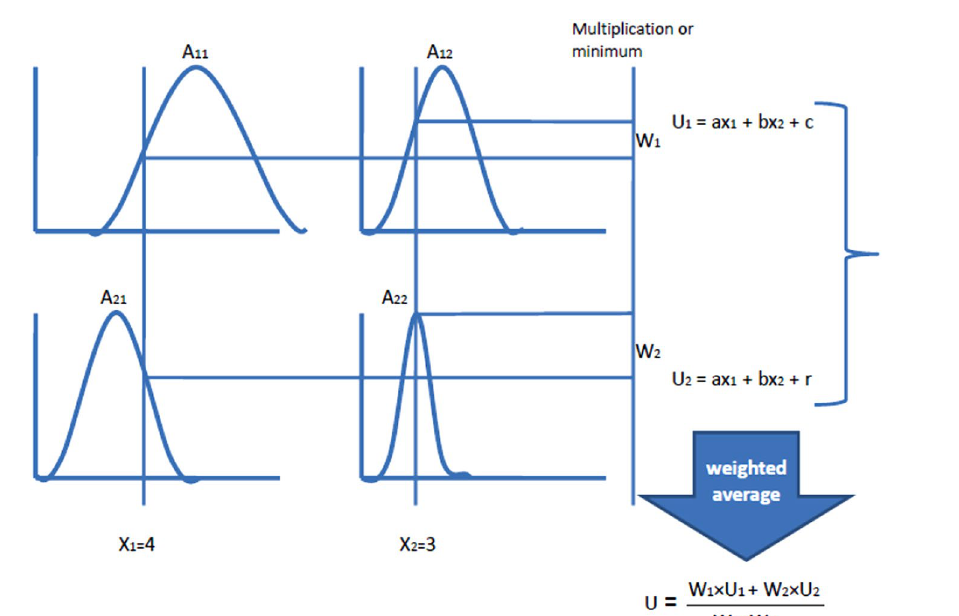
Figure 4. A typical TS inference mechanism for two input